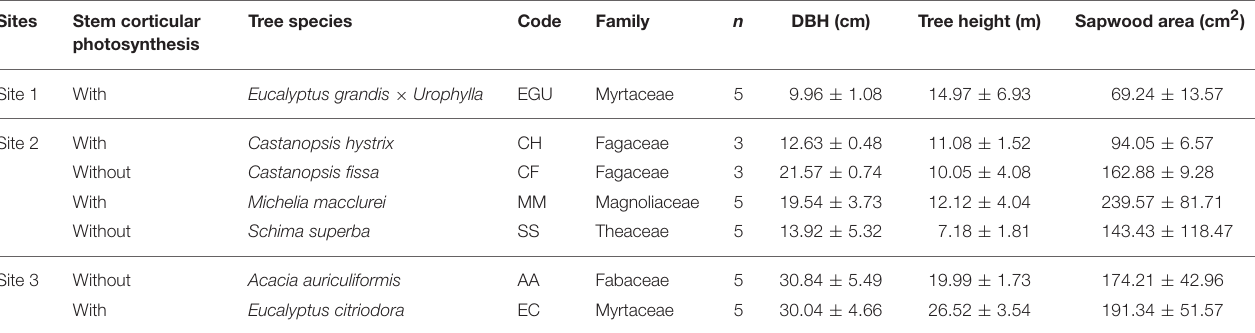
TABLE 1 | Biometric parameters of the sap flow sample trees from the seven studied species in three sites (Site1: Huangmian State Forest Farm; Site 2: Heshan National Field Research Station; Site 3: South China Botanical Garden). Sites Stem corticular